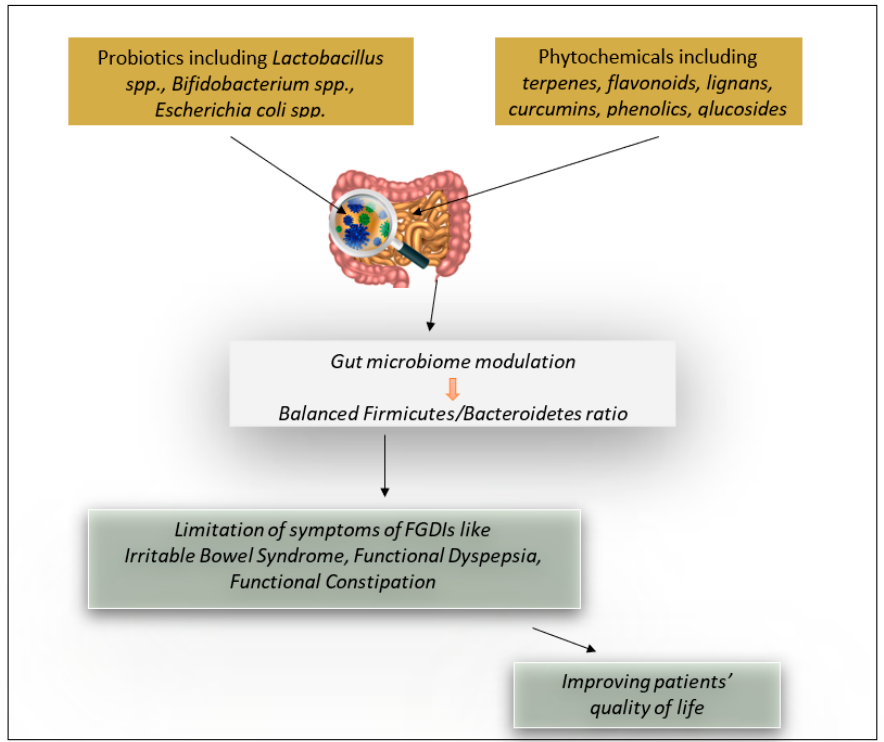
Figure 1. The effect of probiotics and phytochemicals on functional gastrointestinal disorders (FGIDs).